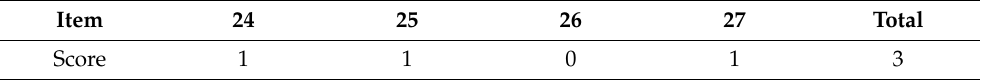
Table 6. Anna’s scores on the four items of the subcomponent companions (CO).